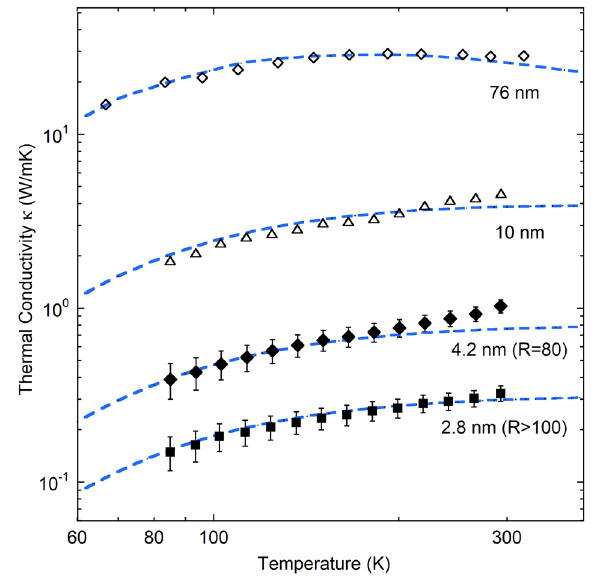
Fig. 6 Fitting thermal conductivity vs. temperature. Two plasma- enhanced chemical vapor-deposited nc -Si fi lms, R = 80 and R > 100, with the average grain sizes of 4.2 and 2.8 nm, respectively, are shown together with a hot-wire chemical vapor-deposited and annealed nc -Si fi lm with grain size of 9.7 nm (ref. 29 ) and a bulk nc -Si sample with grain size of 76 nm (ref. 27 ). The fi tting curves using the Born-von Karman dispersion and frequency-independent (gray) grain boundary scattering explained in the “ Analytical modeling ” section are shown in dashed blue lines. The error bars for plasma-enhanced chemical vapor-deposited nc -Si fi lms are given, as discussed in detail in Supplementary Note 2.